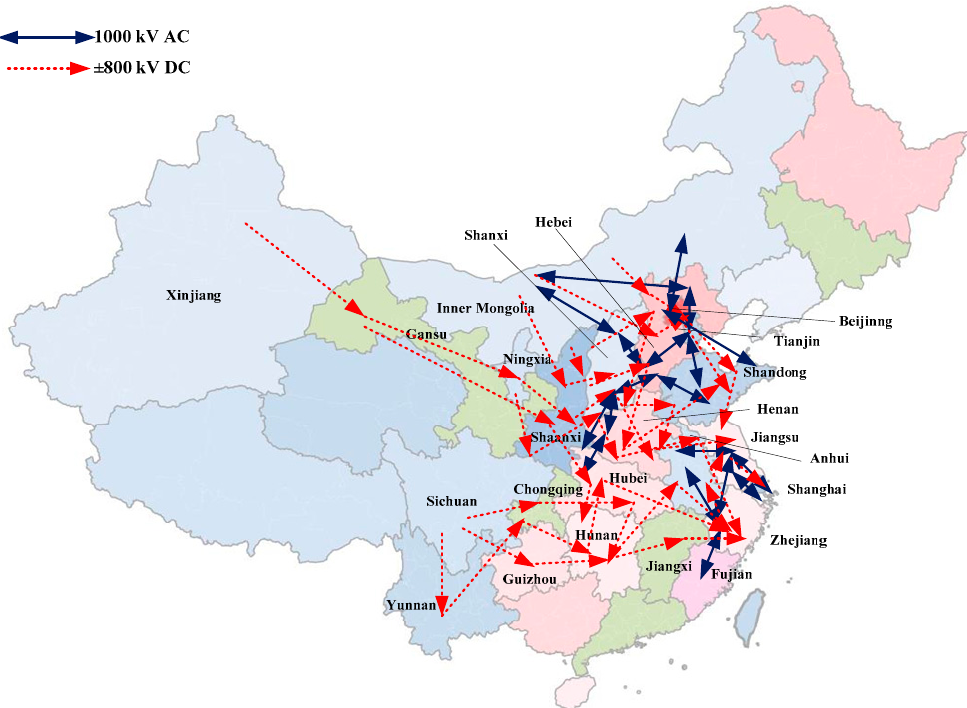
Figure 15. UHV power transmission lines of State Grid by 2017. Table 5. “Eight ACs and Ten DCs” UHV power transmission projects of the State Grid.